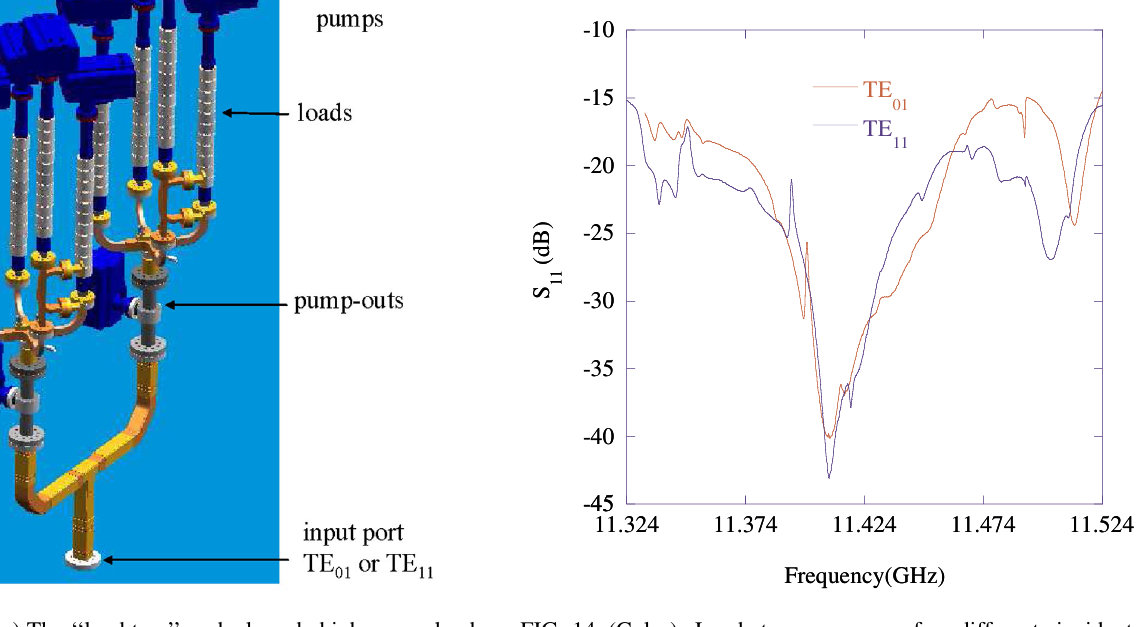
FIG. 14. (Color) Load tree response for different incident